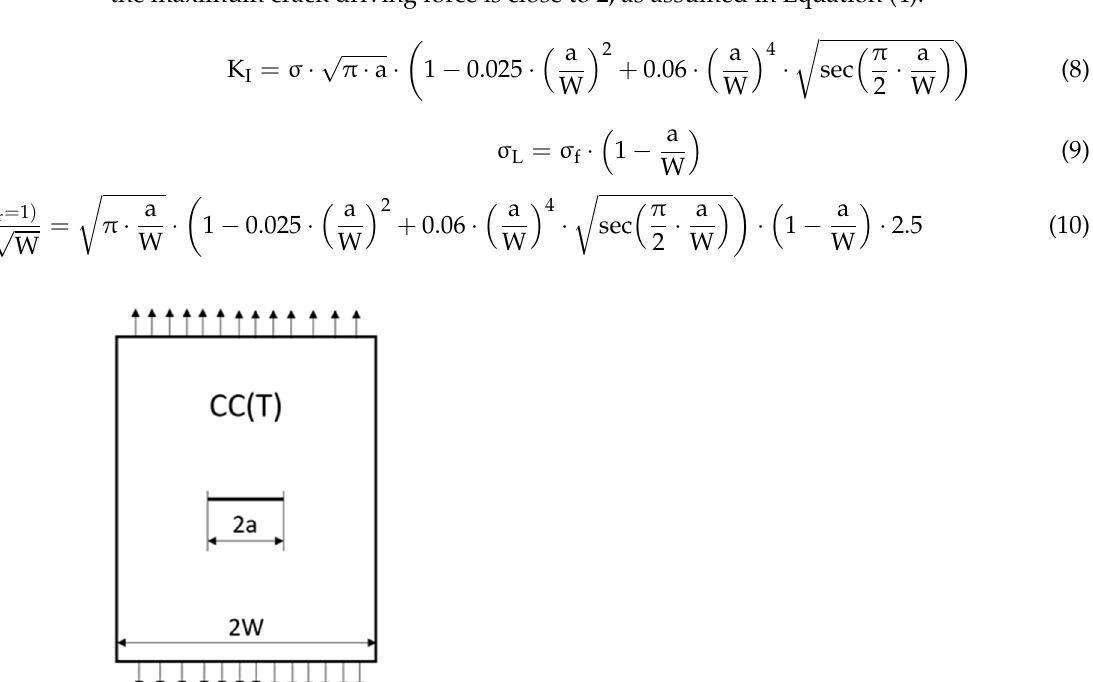
Figure 1. Definition of CC(T) specimen dimensions. The dimensions 2a and 2W are the crack length and specimen width, respectively.